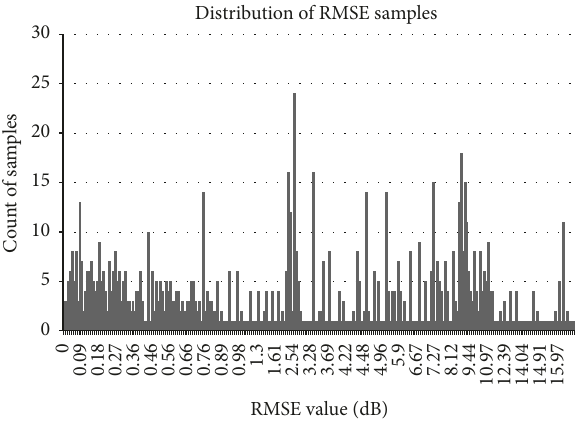
Figure 10: RMSE samples distribution for NLOS cases.